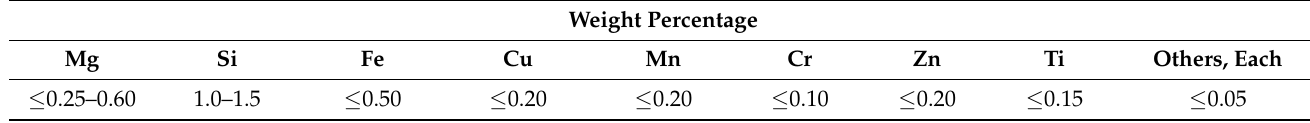
Table 2. Chemical composition of EN AW-6016